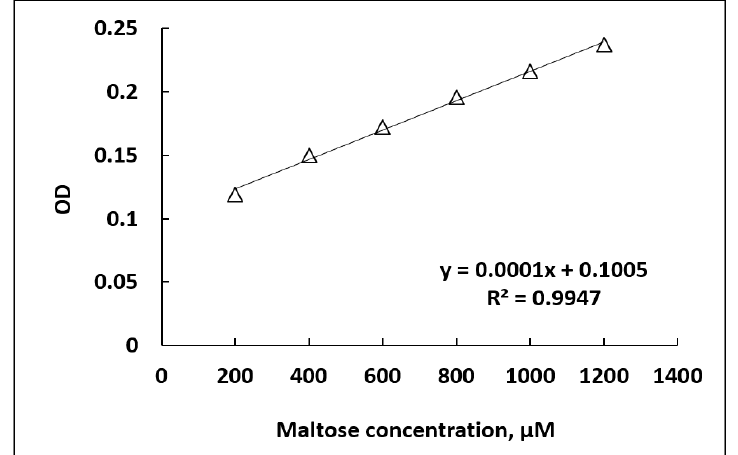
Figure 7. Reduced sugar produced after starch hydrolysis by α -amylase. Conditions: A 1 mL of reaction mixture contained different concentrations of starch (0.06, 1.25, and 1.9%), Tris–HNO 3 buff- ers, PH 7.0, incubates at 37 °C, 1 mL of gelatin-silver reagent (1:3), heated for 10 min at 90 °C, rec- orded absorbance at 434 nm. Each point represents the mean of three experiments ± SE.